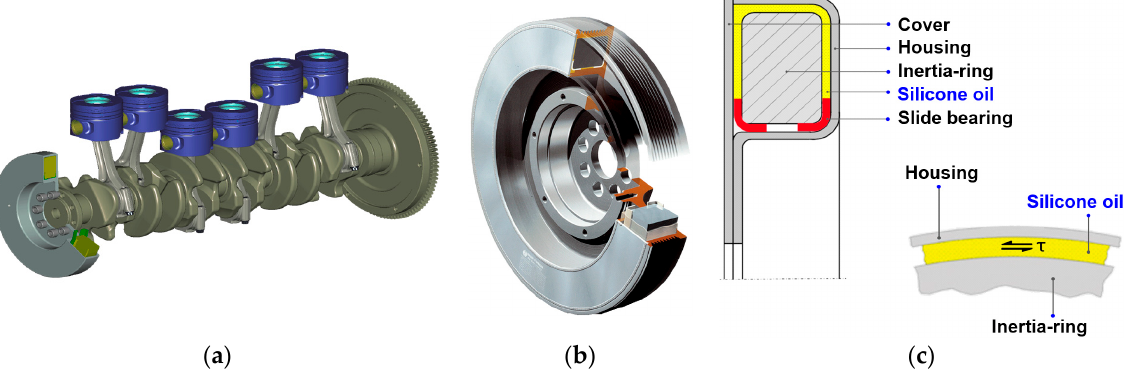
Figure 2. Viscous torsional vibration damper ( a ) mounted on the free end of a crankshaft (reproduced with permission from P. Érsek [3]), ( b ) 3D model (reproduced with permission from Hasse & Wrede [4]) and ( c ) elements and structure (reproduced with permission from Hasse & Wrede [4]).